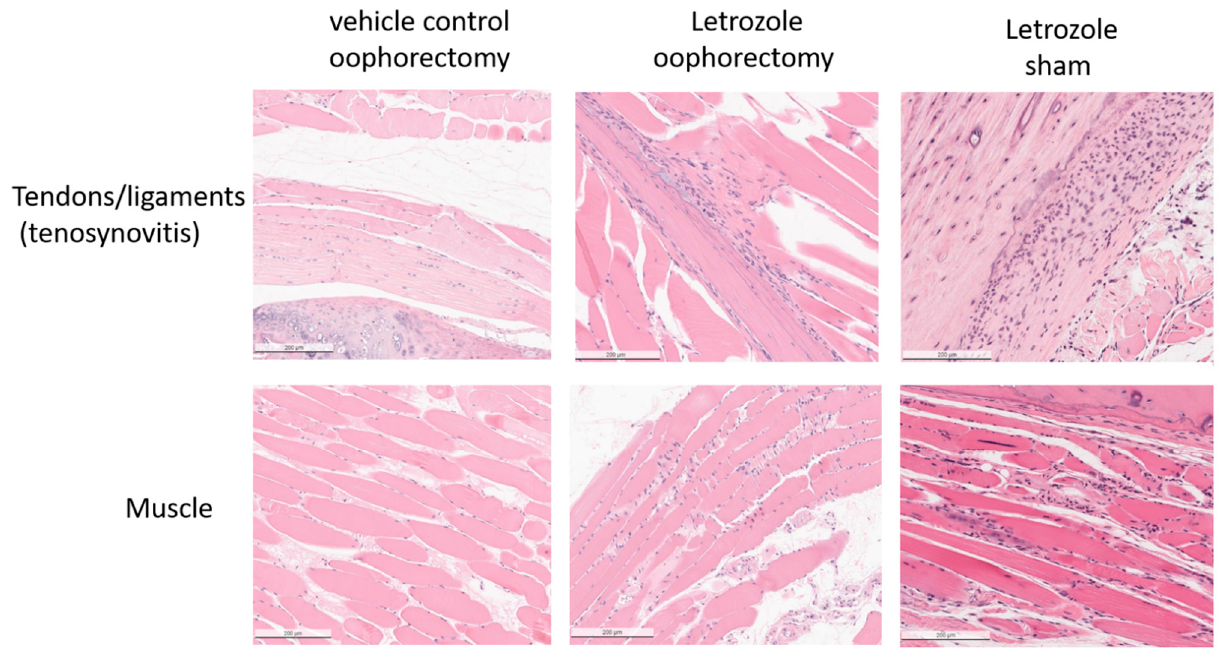
Figure 4. Histopathological analysis of mice receiving aromatase inhibitor treatment indicates tenosynovitis and myositis. H&E staining of tissue sections taken from female NF κ B-RE-luc mice after 5 weeks of subcutaneous letrozole treatment. Muscle tissue sections were dissected from legs and processed for H&E staining and histopathology. Cellular infiltrates are present in tendons and muscles with treatment of the aromatase inhibitor letrozole independent of oophorectomy or sham surgery.